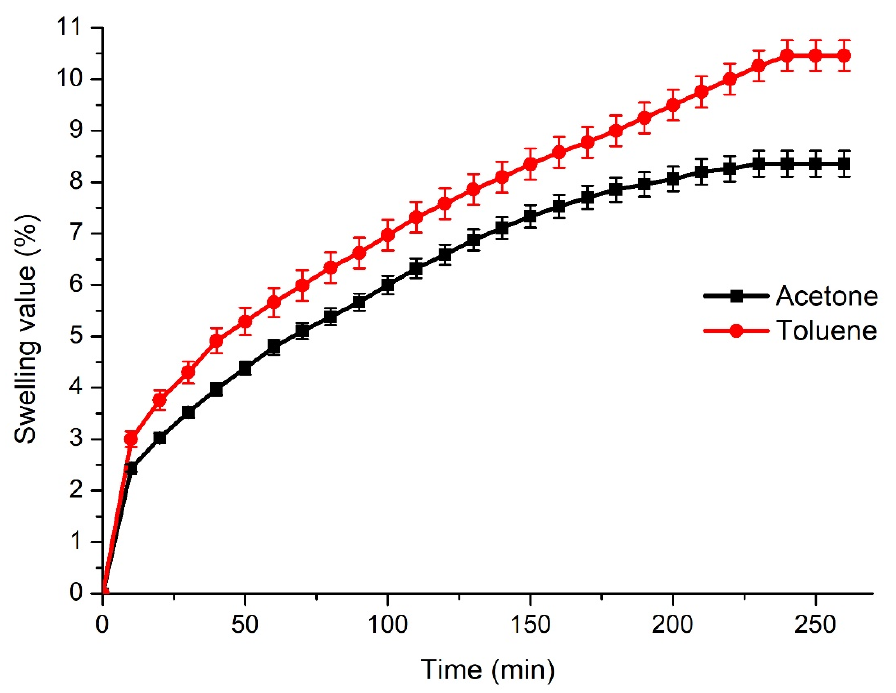
Figure 4. Swelling values of the polymer VS in acetone and toluene.